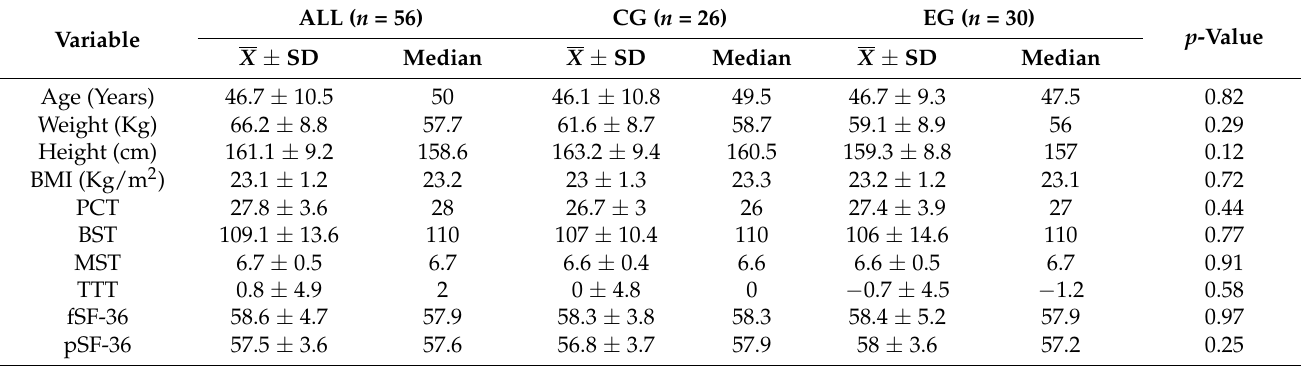
Table 3. Baseline of the studied